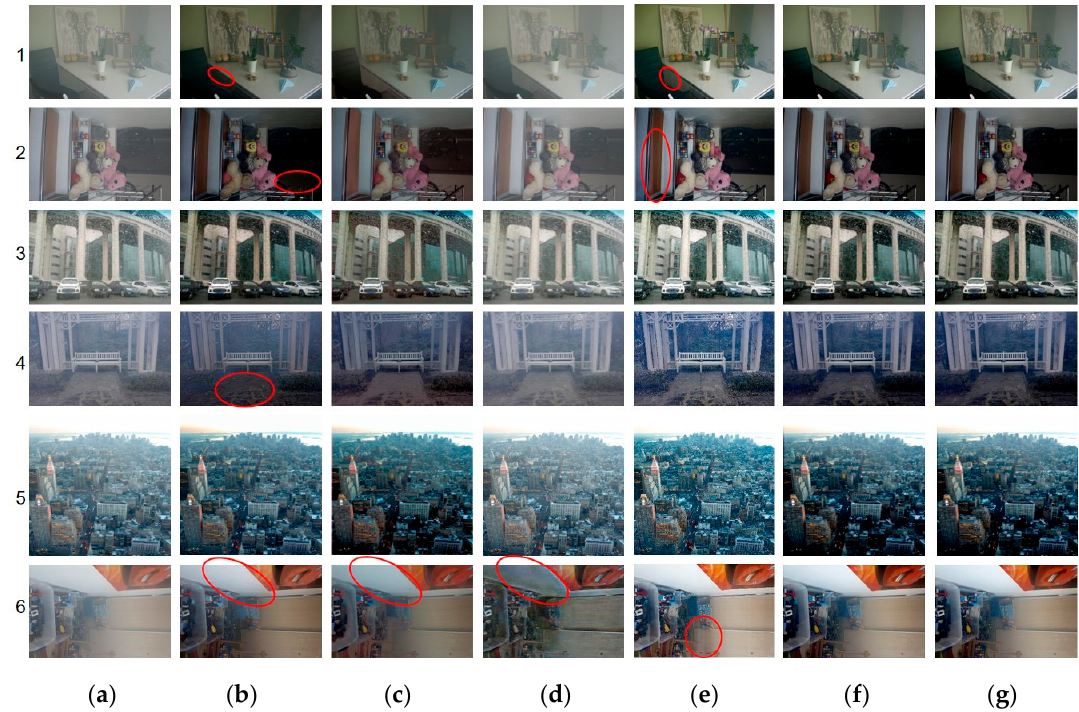
Figure 5. Qualitative comparisons of real-world hazy images. ( a ) Hazy Inputs; ( b ) DehazeNet [6]; ( c ) all-in-one dehazing (AOD) [8]; ( d ) Cycle [9]; ( e ) filter-refined dark-channel-prior (F-DCP) [15]; ( f ) TGL-Net-Syn; ( g ) TGL-Net-Mix.